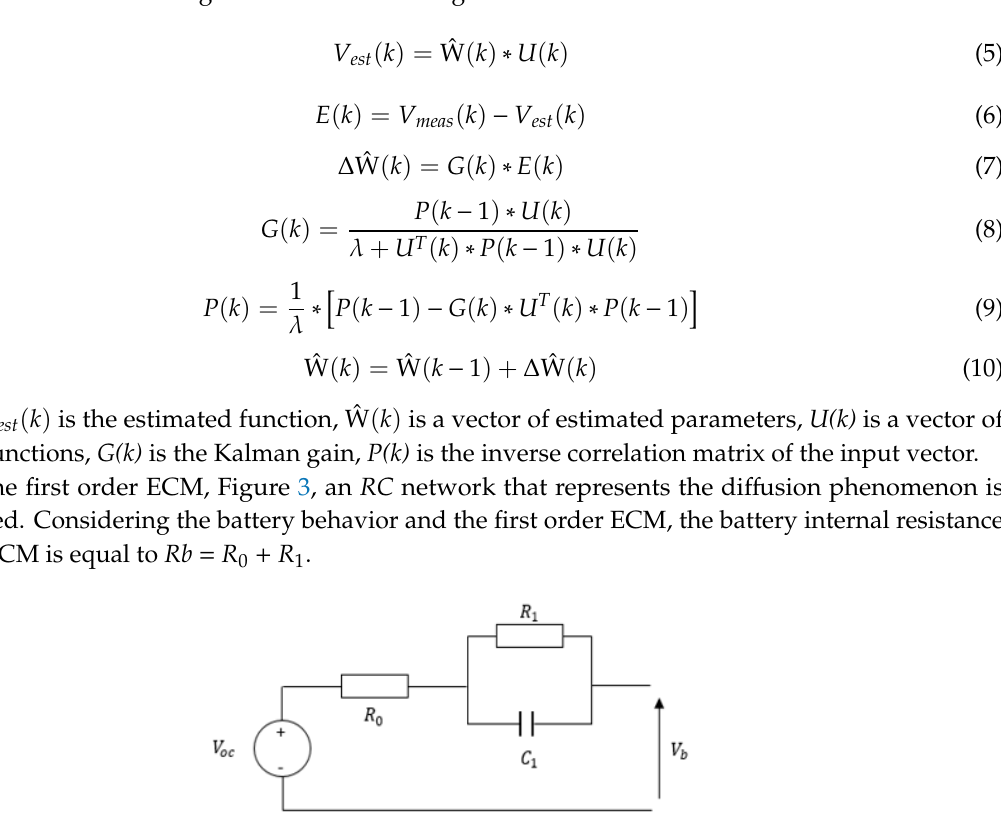
Figure 3. Battery first order Equivalent circuit model (ECM).